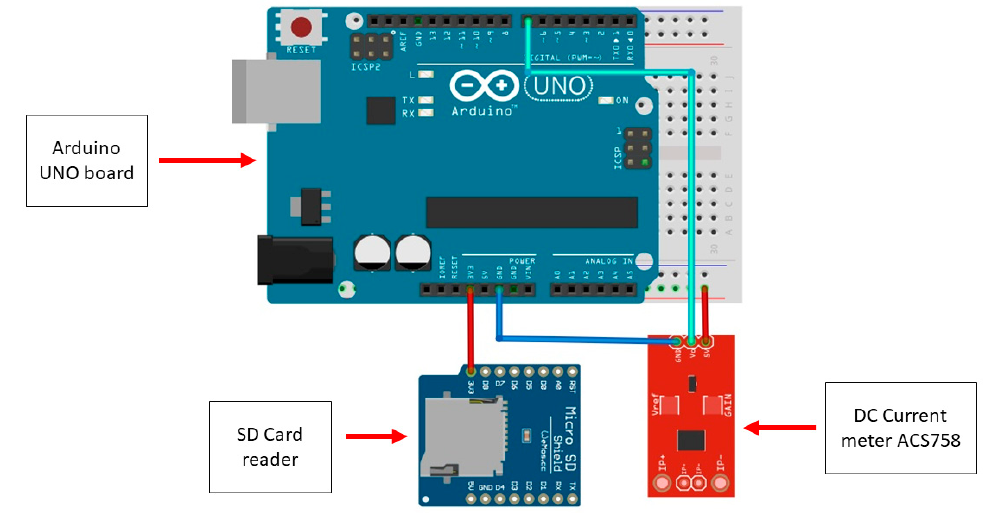
Figure 11. Connections diagram of the monitoring system.